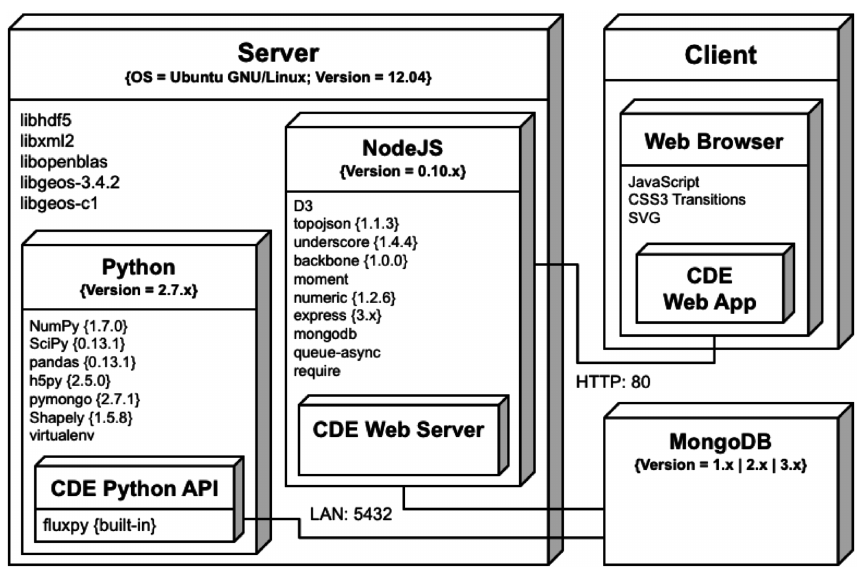
Figure 2. A unified modeling language (UML) deployment diagram for the Carbon Data Explorer (CDE), illustrating the configuration and connections between the components as currently